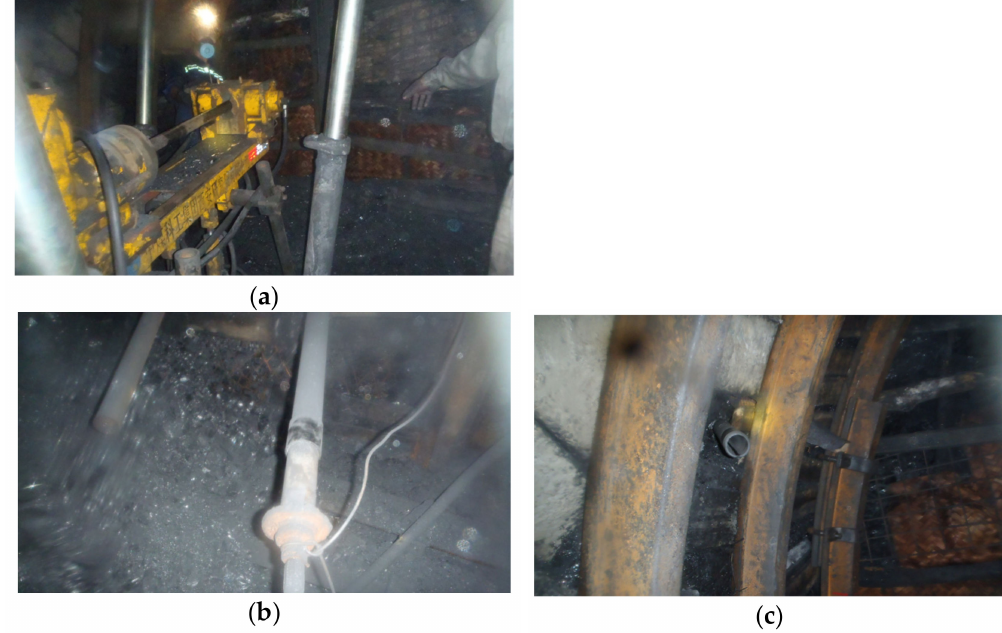
Figure 6. Pictures taken in the field: ( a ) drilling; ( b ) steel tube installing; and ( c ) water